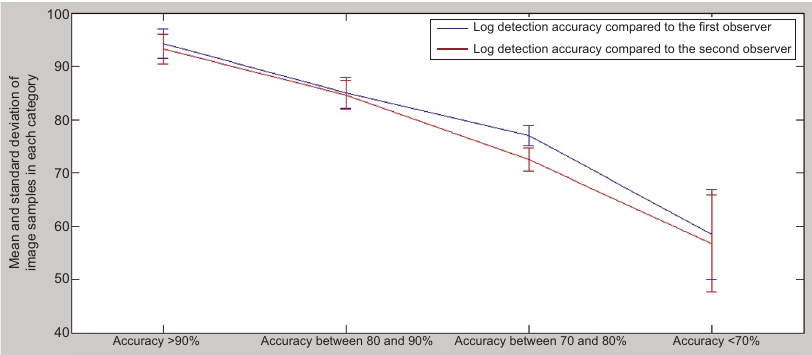
Figure 6. Mean and Standard Deviation of the Image Samples Grouped into Four